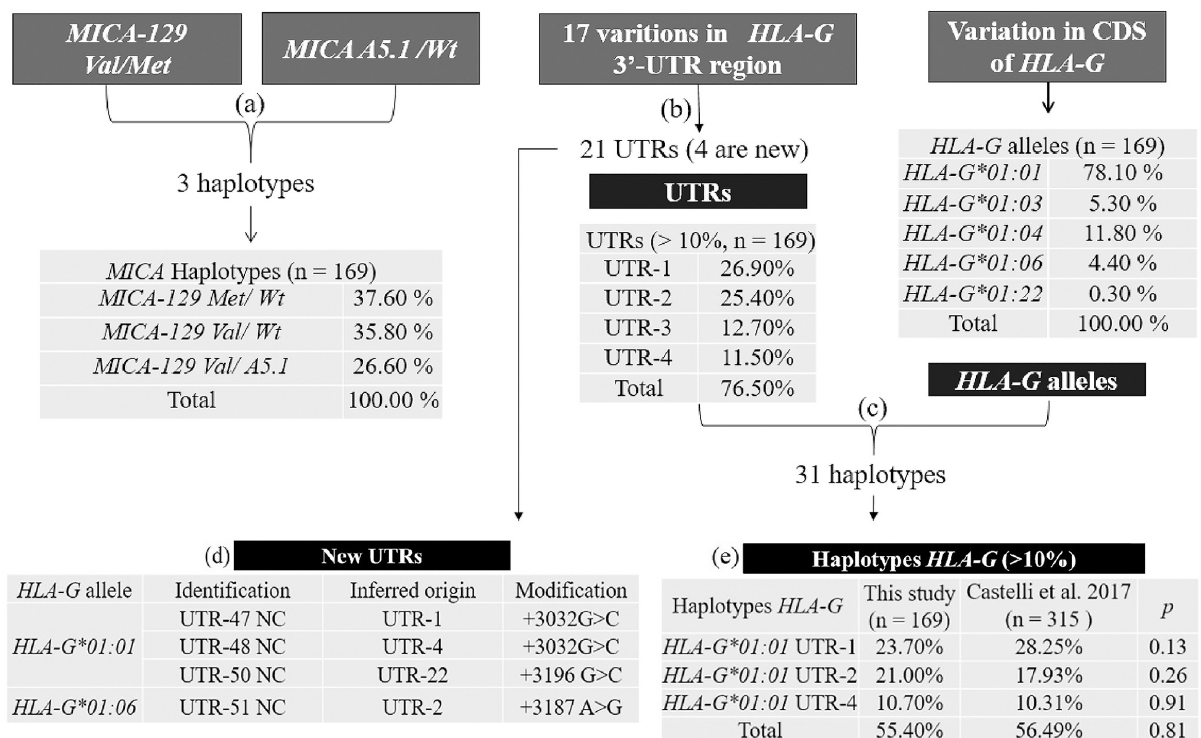
Fig 1. The three steps (a, b and c) of haplotype inference, HLA-G allele frequencies, and haplotype frequencies found in all samples (n = 169). Haplotype inferences: MICA-129 Val/Met and MICA A5 . 1/Wt (a) , between 17 variations found in 3’-UTR of the HLA-G gene (b) , and HLA-G UTRs and alleles (c) . New UTRs described and their inferred origin (d) . Similarity of frequencies of HLA-G haplotypes with published data from a population in S ã o Paulo [18] (e) . Wt : wild type, which does not show MICA A5 . 1 variation. CDS: coding DNA sequence (exon 2, 3 and 4 of the HLA-G gene). Del : +2960 or 14-bp deletion and Ins : +2960 or 14-bp insertion. NC: new